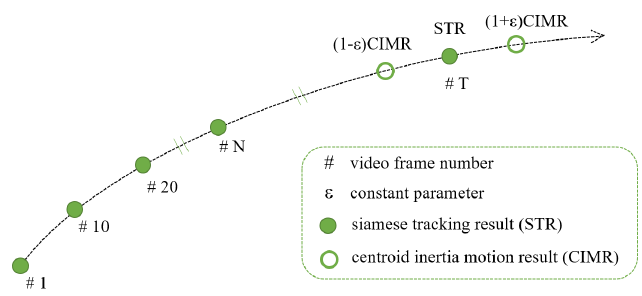
Figure 3. The mechanism of the proposed ID-CIM